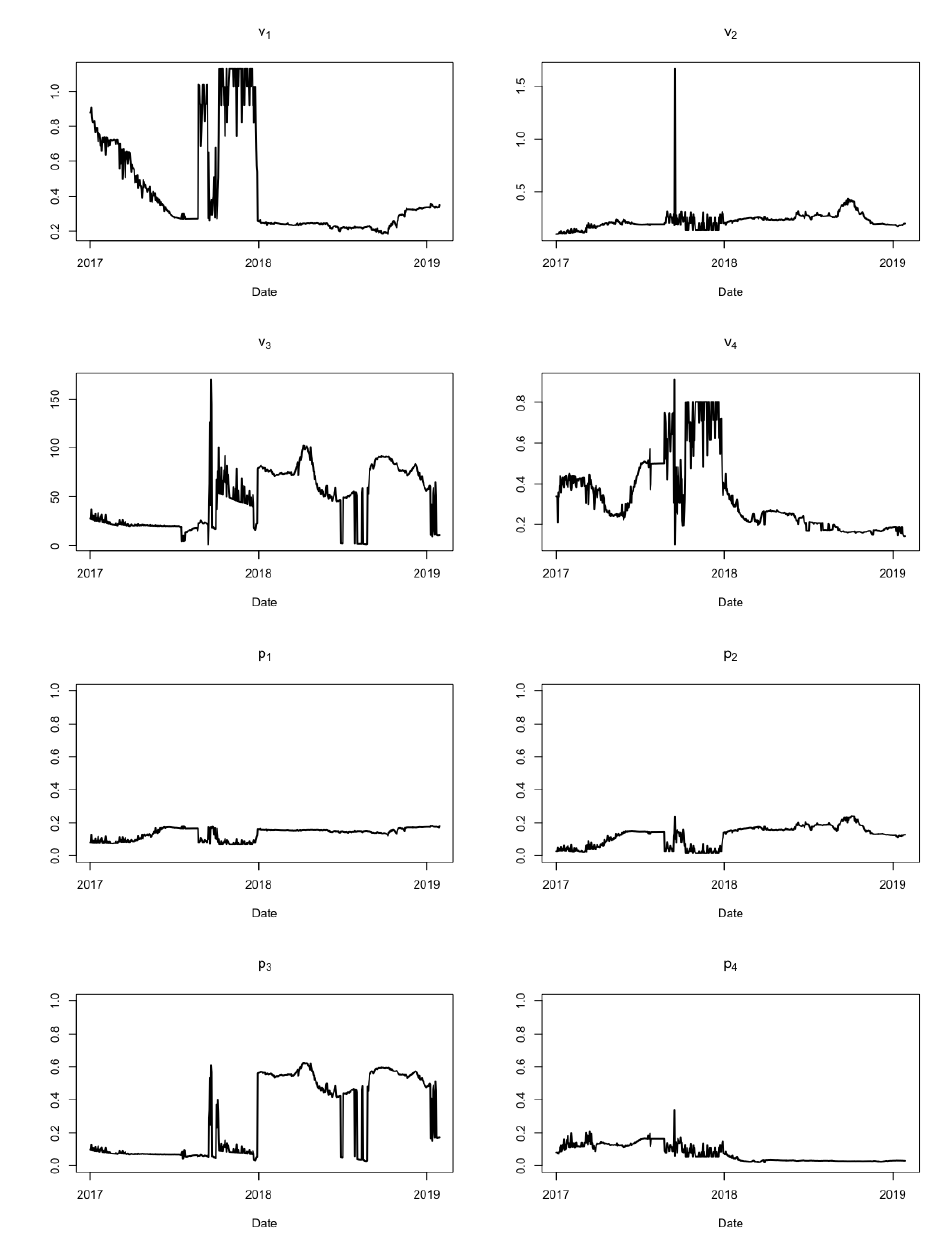
Figure 6. Expanding window: dwell-time parameters for the homogeneous four-state normal HSMM on BTC/USD daily log